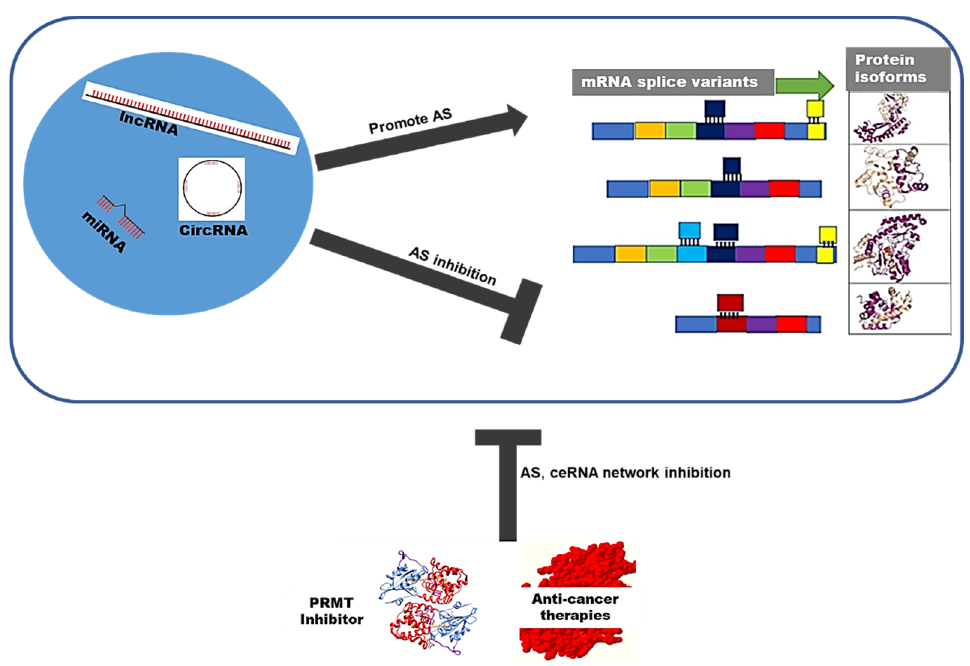
Figure 5. PMRT inhibitors drug therapeutic potential. The ceRNA network regulates AS by encour- aging or inhibiting the generation of protein isoforms. PRMT inhibitor drugs can counter the effects of the ceRNAs network by disrupting AS. PRMT inhibitors may also be used with other anticancer therapies to enhance their